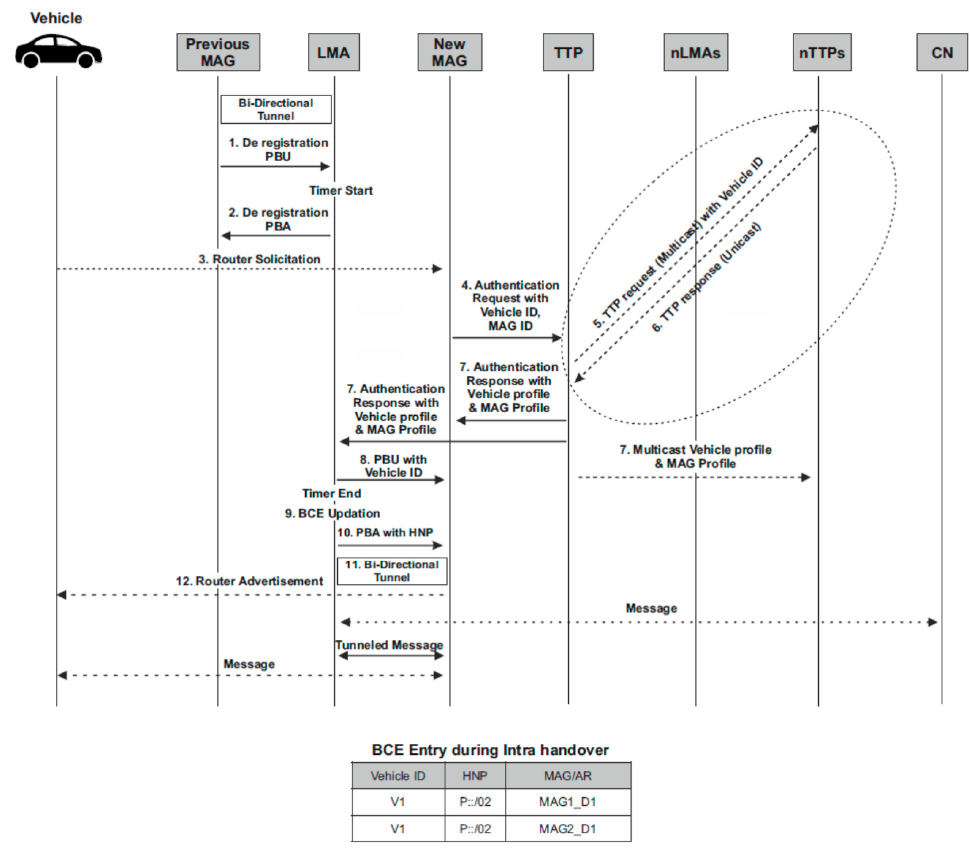
Figure 4. Sequence diagram for intra-domain handover for a vehicle in the PMIPv6 domain.